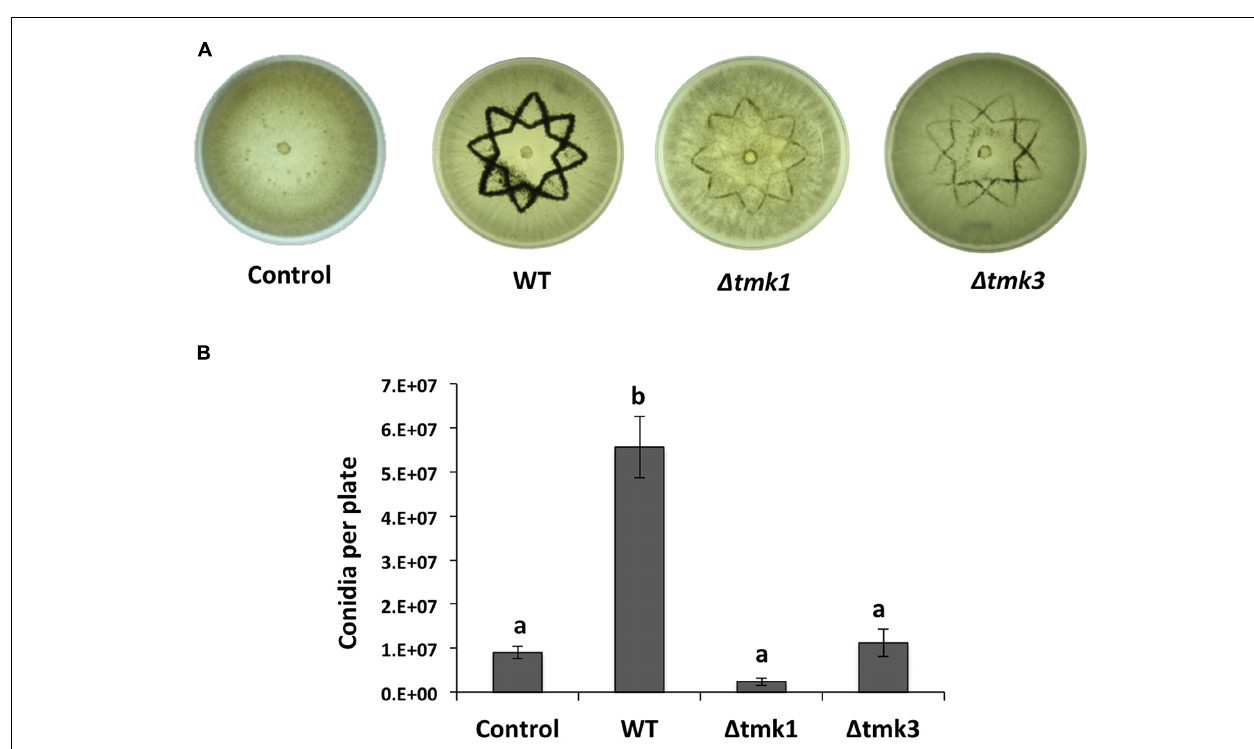
FIGURE 3 | Injury response of theTmk1 andTmk3 mutants. (A) TheWT, (cid:2) tmk1 and (cid:2) tmk3 strains growing on PDA were damaged with a cookie mold, and photographs taken 48 hours later.An undamagedWT strain is shown as